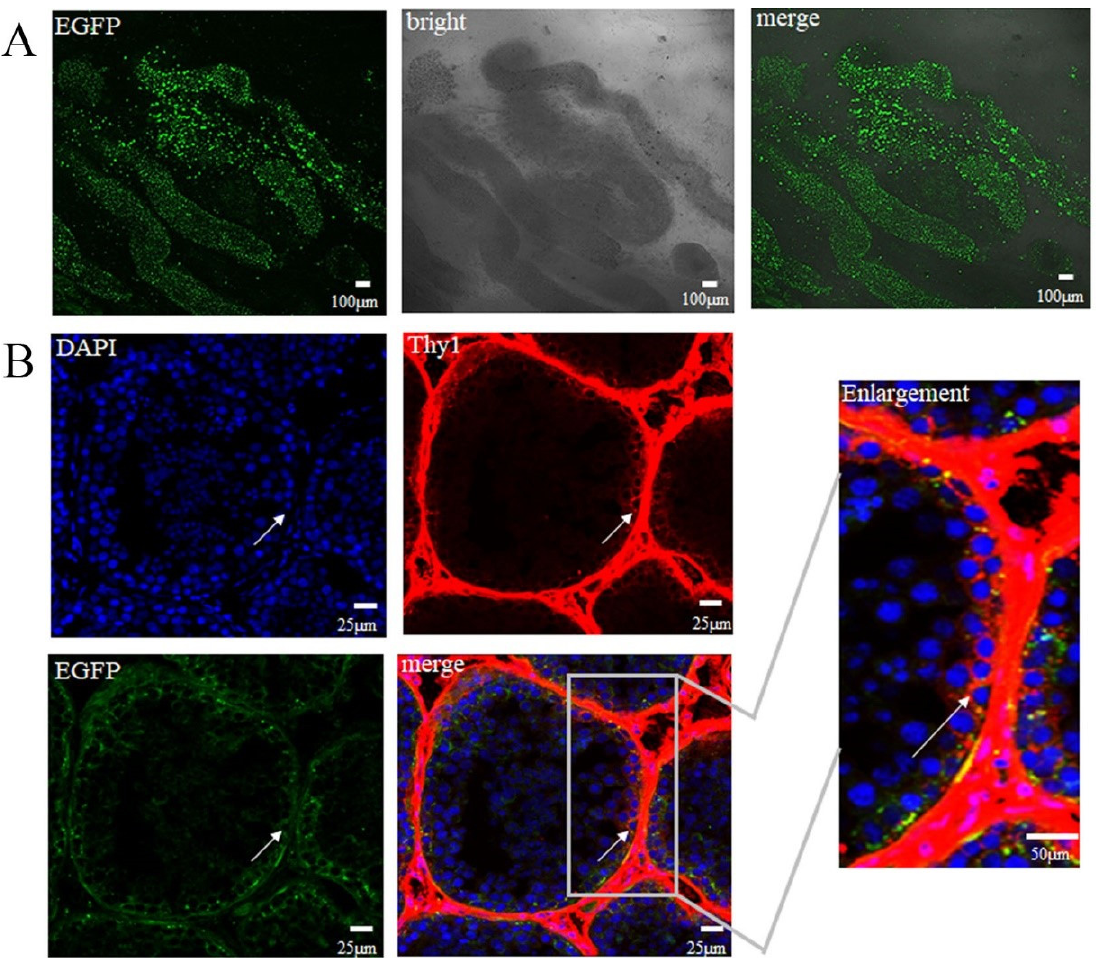
Figure 3. SSCs successfully carried the EGFP gene. ( A ) Green fluorescence signal of EGFP was observed in the seminiferous tubule tissue. ( B ) Thy1, a specific marker on the surface of SSCs; SSCs carried the EGFP gene ( n = 3). The arrows represent SSCs.